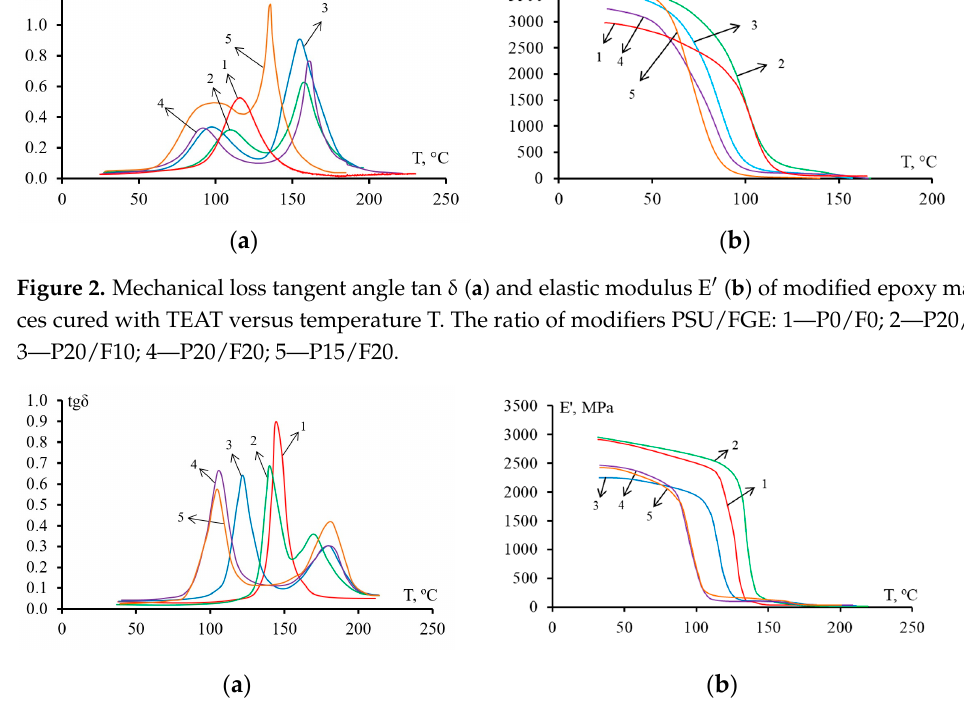
Figure 3. Mechanical loss tangent angle tan δ ( a ) and elastic modulus E’ ( b ) of modified epoxy matrices cured with iso-MTHPA versus temperature T. The ratio of modifiers PSU/FGE: 1–P0/ F0; 2– P20/F0; 3–P20/F10; 4–P20/F20; 5–P30/F20.